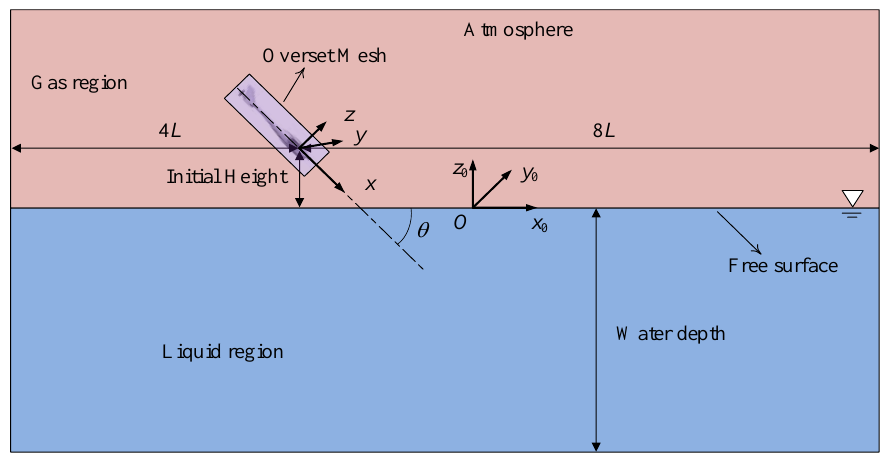
Figure 1. The sketch of the problem definition.